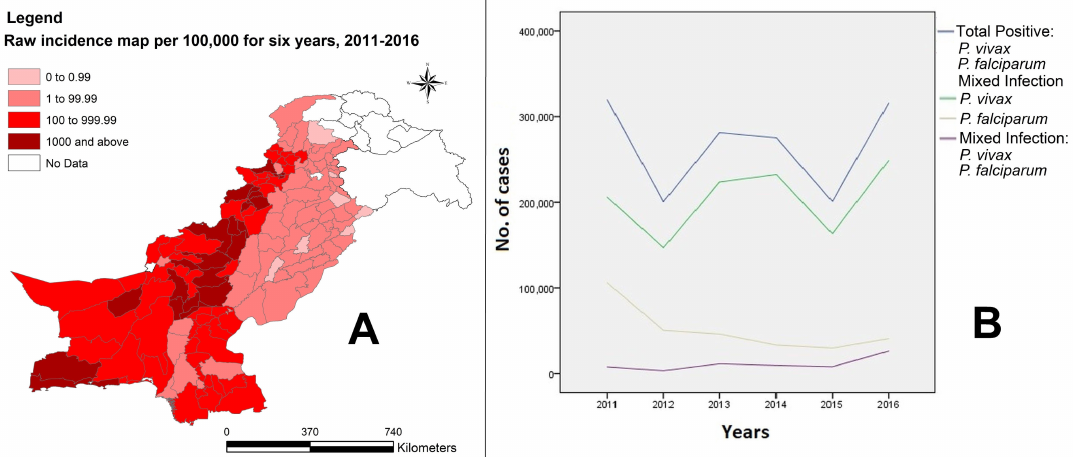
Figure 2. ( A ) Raw incidence (per 100,000) of aggregated total positive cases at the district level in Pakistan, and ( B ) sequence plot of annual cases of malaria by type in Pakistan,